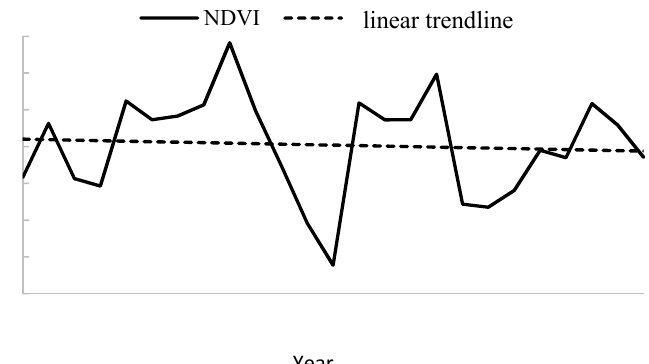
Figure 7. Long ‐ term average NDVI in the Fenhe River basin. Figure 7. Long-term average NDVI in the Fenhe River